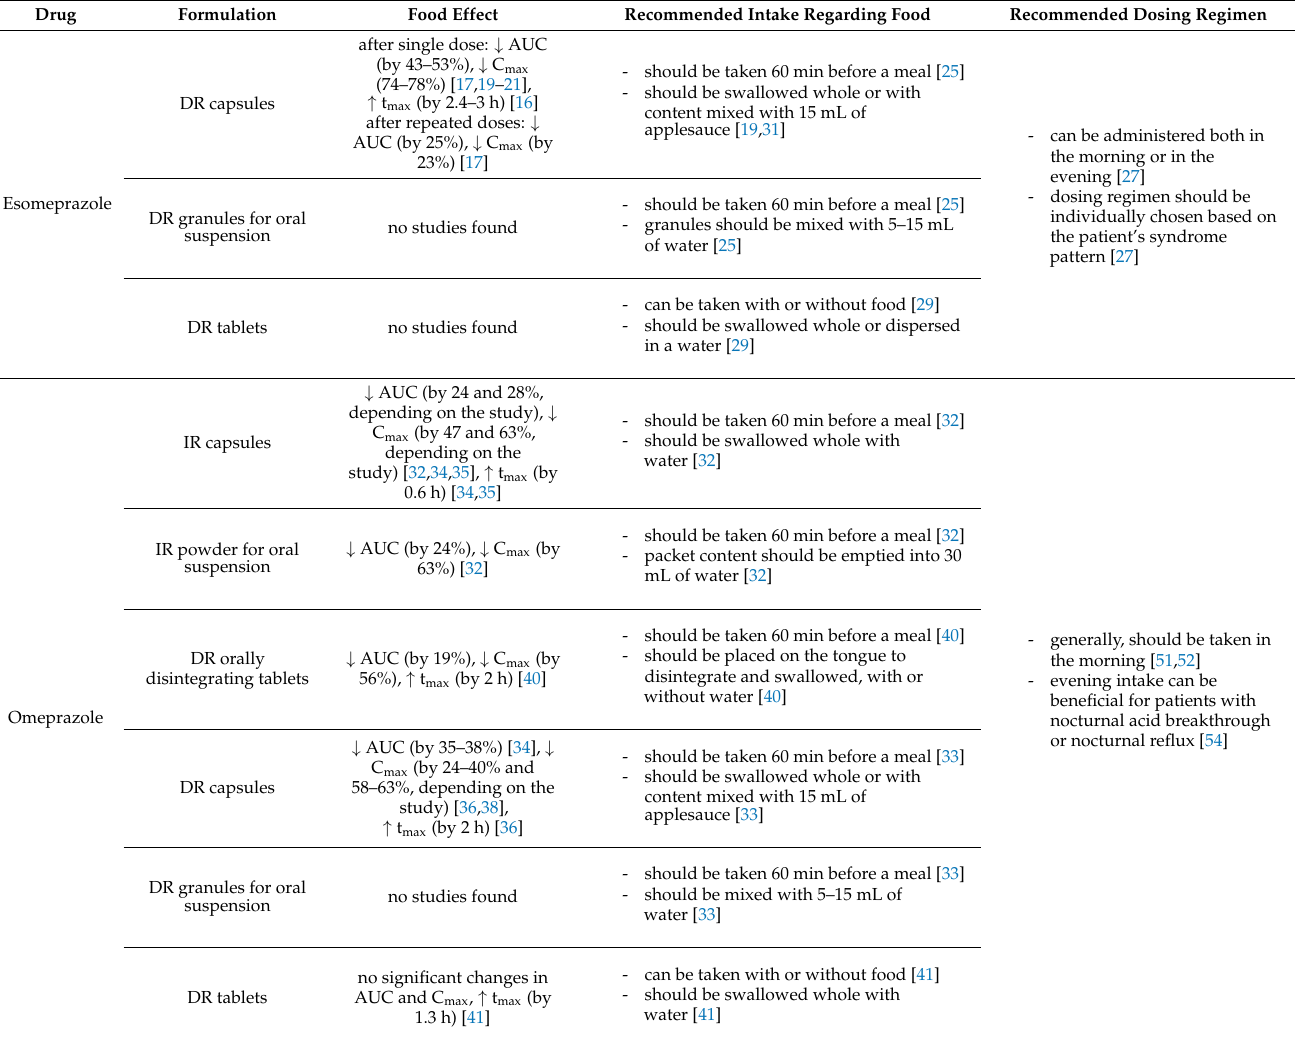
Table 1. Summary of recommendations for appropriate intake of different formulations of proton pump inhibitors with food and the time of the